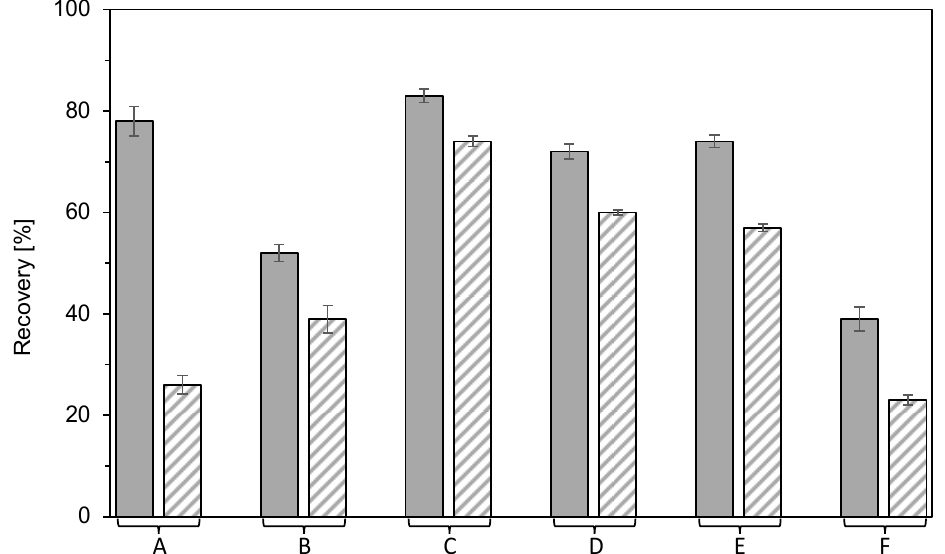
Figure 8. Effect of eluent composition ( A ) 2 M NaCl in tris pH 8, ( B ) phosphate buffer pH 5.8, ( C ) 2 M NaCl in phosphate buffer pH 5.8, ( D ) citrate-phosphate buffer pH 3.6, and ( E ) 0.5 M Na 2 SO 4 in tris pH 8 on BSA recovery, and ( F ) 2 M NaCl in tris pH 8 on DNA recovery. Grey bars represent results for immediate elution after adsorption and washing steps (no incubation). Bars with stripes represent the recovery of membranes that were incubated for 12 h after the adsorption and washing steps. Error bars represent standard deviations.